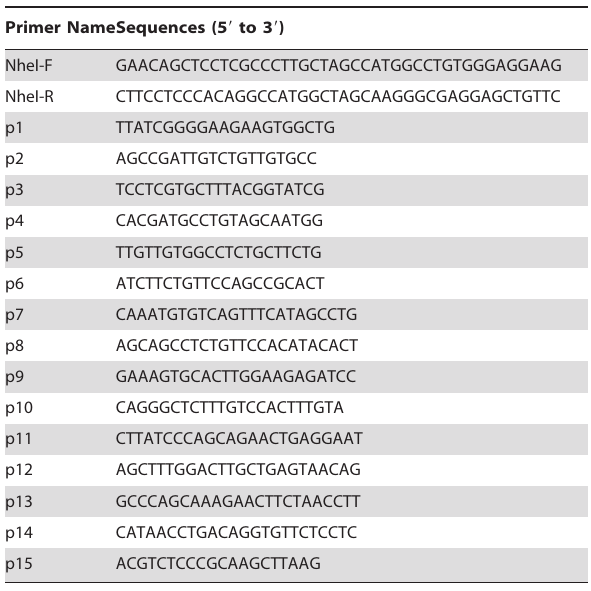
Table 1. Primers used for mutagenesis and for amplifying the 5 9 and 3 9 junction sequences, TK coding sequence, and plasmid backbone